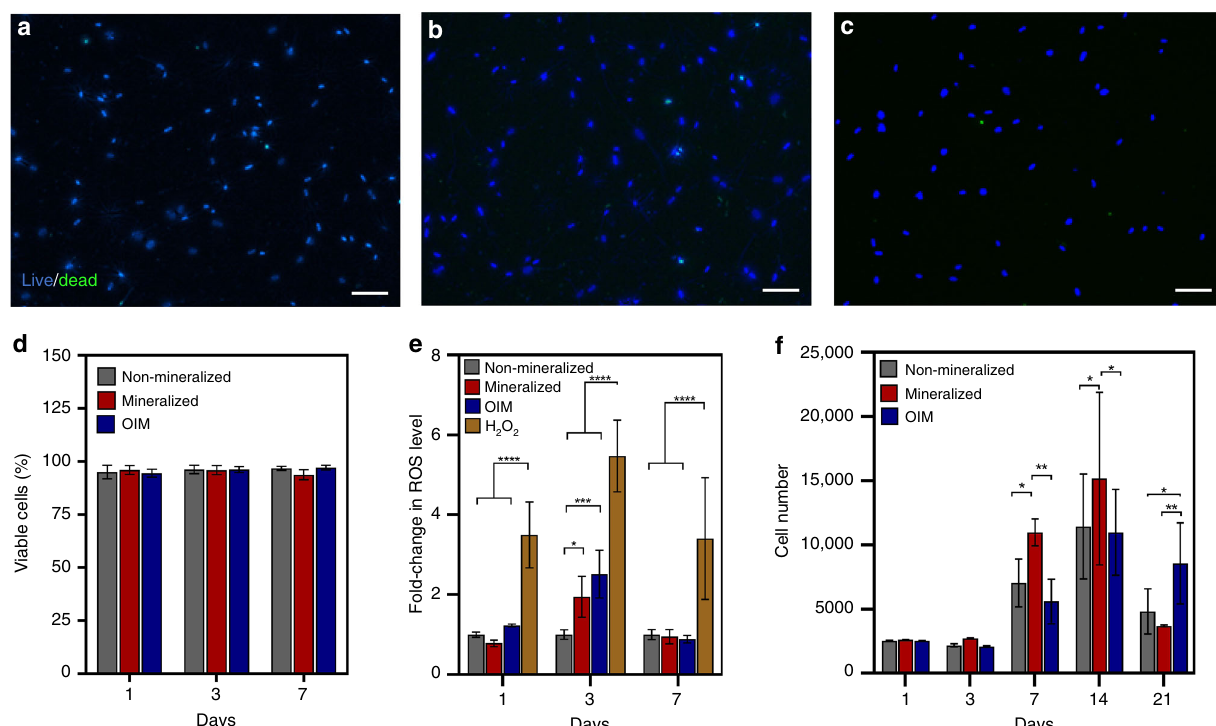
Fig. 2 Cytocompatibility of the biomineralization process. Representative fl uorescent micrographs of live (blue) and dead (green) stained hMSCs embedded in ( a ) non-mineralized, ( b ) mineralized, and ( c ) OIM-treated hydrogels after 7 days. Scale bar: 100 µ m. d All groups showed more than 90%